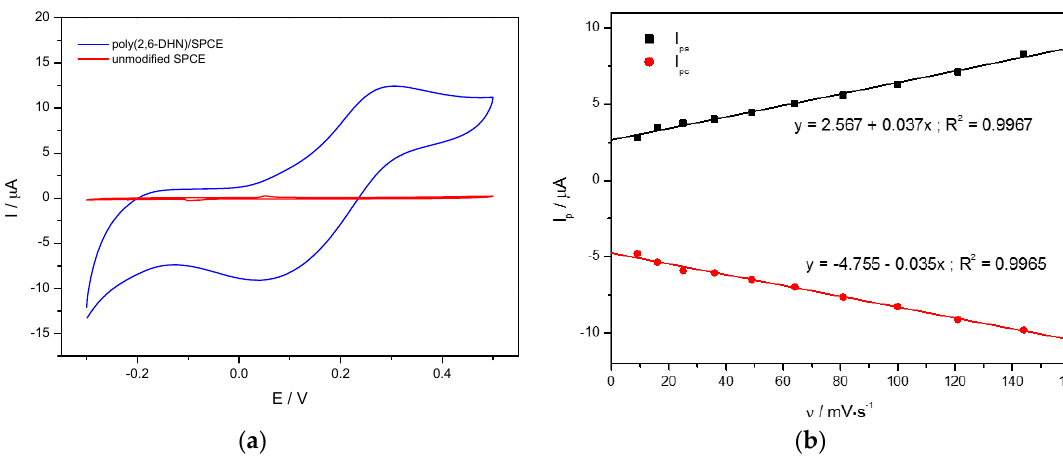
Figure 5. ( a ) CVs for poly(2,6-DHN)/SPCE and unmodified SPCE in 0.1 M PBS pH 9.0 . Scan rate 100 mV · s − 1 ; potential range: − 0.3 V to +0.5 V; sensor modified by electropolymerization of 2,6-DHN with the scan rate = 5 mV · s − 1 . ( b ) Dependence of the anodic and cathodic peak currents (I p ) on scan rate ( ν ) for poly(2,6-DHN)/SPCE in 0.1 M PBS pH 9.0. Scan rates: 9–144 mV · s − 1 ; sensor modified by electropolymerization of 2,6-DHN with the scan rate = 5 mV · s − 1 .